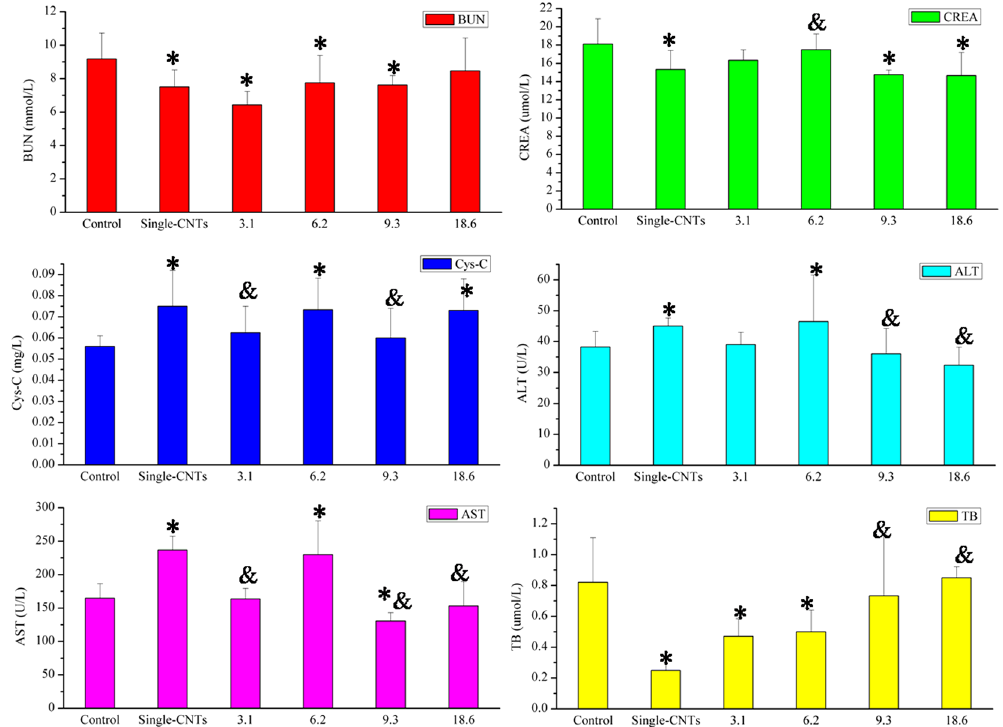
Figure 8. The biochemical indices level of BUN (blood urea nitrogen), CREA (creatinine), AST (aspartate aminotransferase), Cys-C (cystatin C), ALT (alanine aminotransferase), CRP (C-reaction protein) and TB (total bilirubin) change in plasma after exposure 3.1, 6.2, 9.3 and 18.6 mg/kg.bw TD to oMWCNTs-model mice